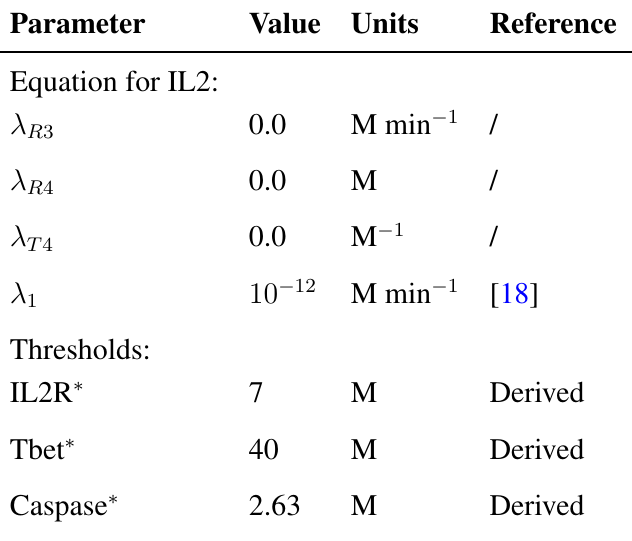
Default parameter settings for simulations: extracellular level and molecular thresholds for T-cell differentiation and